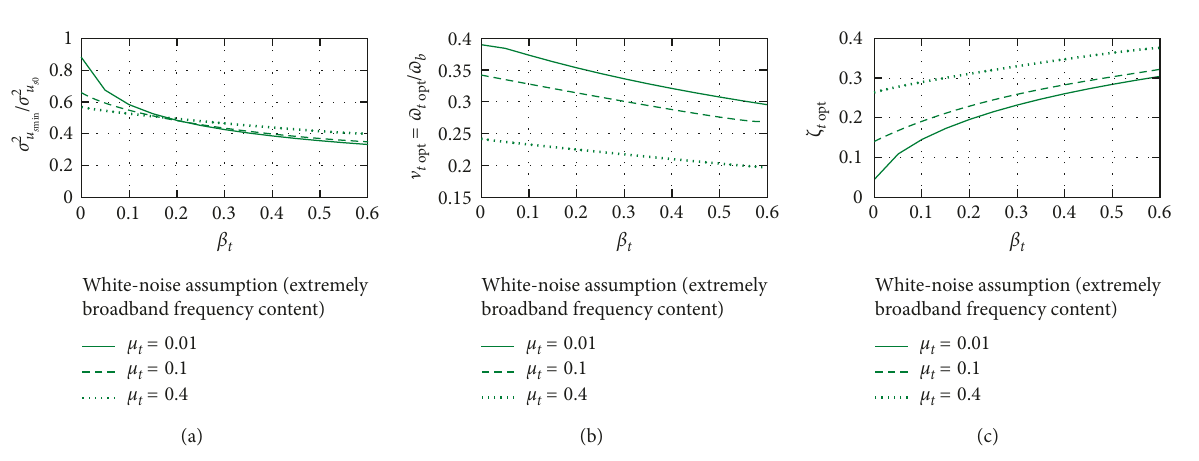
Figure 9: Optimal TMDI tuning for white-noise assumption for the earthquake: (a) minimum OF achieved, normalized with respect to the case without TMDI; (b) optimal frequency ratio; (c) optimal damping ratio are shown, namely μ t 0 . 01 that is representative of (cid:28) a small-mass flywheel device as shown in Figure 2, μ t 0 . 1 (cid:28) that is relevant to a conventional TMD system, and μ t 0 . 4 (cid:28)